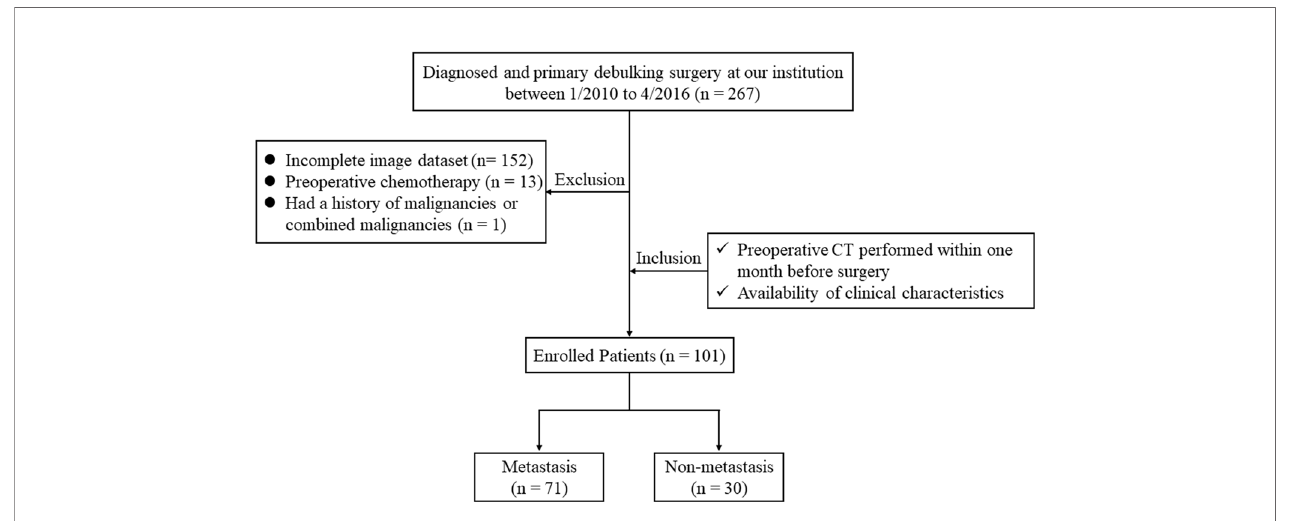
FIGURE 1 | The fl owchart of the case identi fi cation